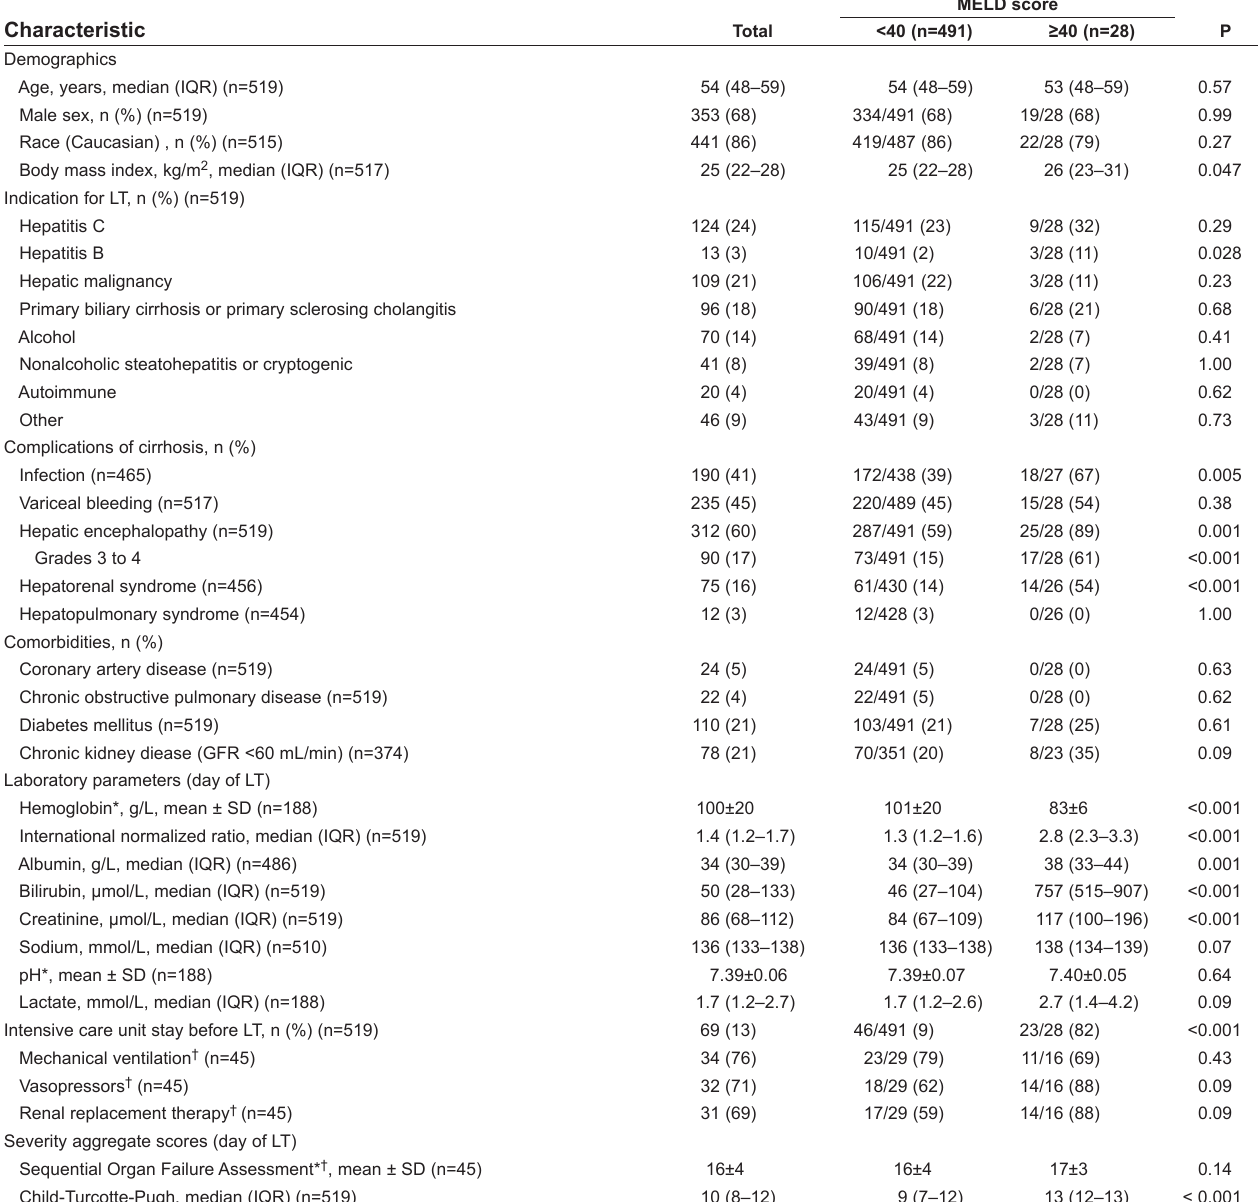
TABLE 1 Analysis of patients’ pre-liver transplant (LT) characteristics for the entire cohort and according to Model for End-stage Liver Disease (MELD) score (≥40 versus <40) categories at LT